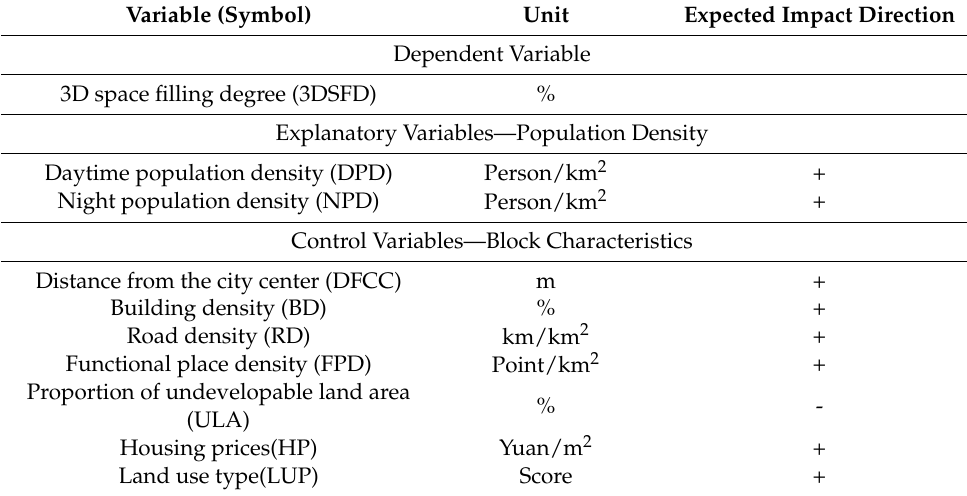
Table 1. Definitions and evaluation methods for the